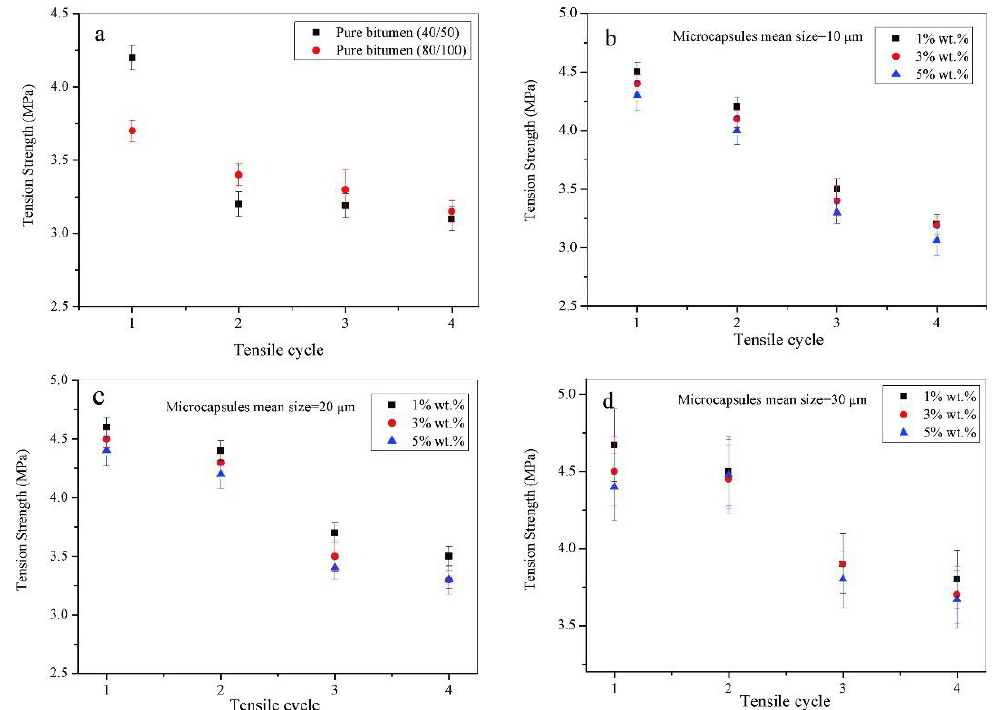
Figure 6. Tension strength values of microcapsules/bitumen samples during a reparative fracture-healing process (four recycles) under temperature of 0 ˝ C, microcapsules contents are 1.0, 3.0 and 5.0 wt. %; ( a ) tension strength values of pure bitumen (80/100) and bitumen (40/50), tension strength values of bitumen samples with microcapsules mean size of; ( b ) 10 µ m; ( c ) 20 µ m; and ( d ) 30 µ